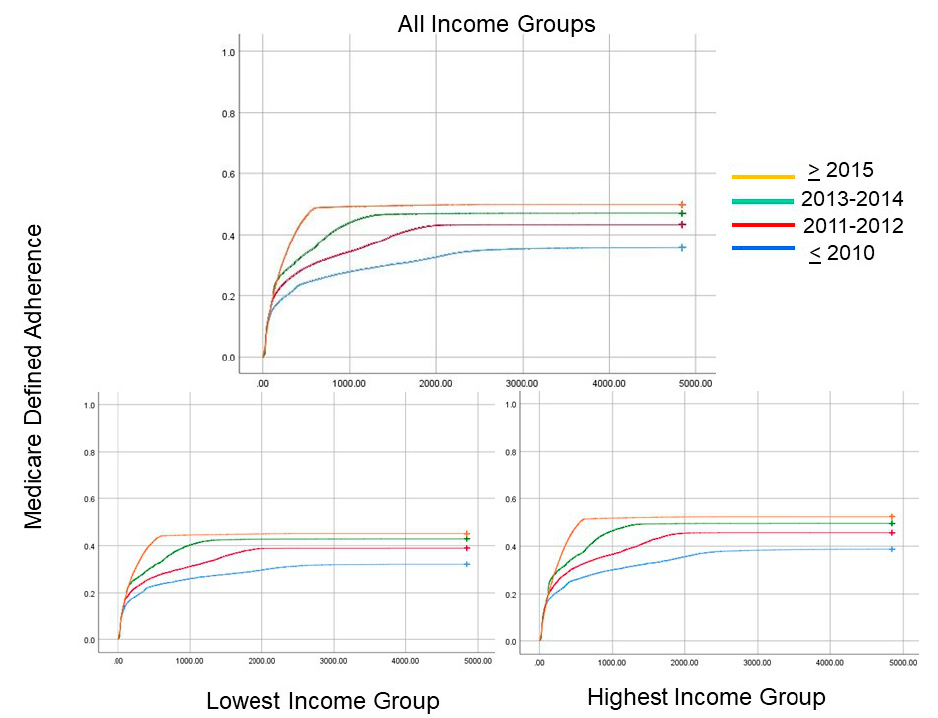
Figure 5. (a) The upper panel shows Kaplan–Meir curves that reveal differences in the temporal pattern of adherence to positive airway pressure (PAP) therapy (by Medicare-defined criteria) based upon the year of set-up or PAP initiation. Note that progressively after 2010 there is a greater proportion of individuals who are adherent by Medicare standards and they accomplish such adherence earlier in time after their device is set-up (Log Rank; p < 0.0001). The lower panels reveal similar graphs for the ( b ) lowest and ( c ) highest income